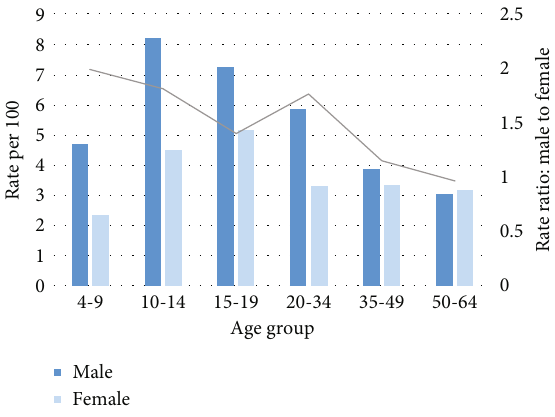
Figure 1: Rate of ADHD according to age and